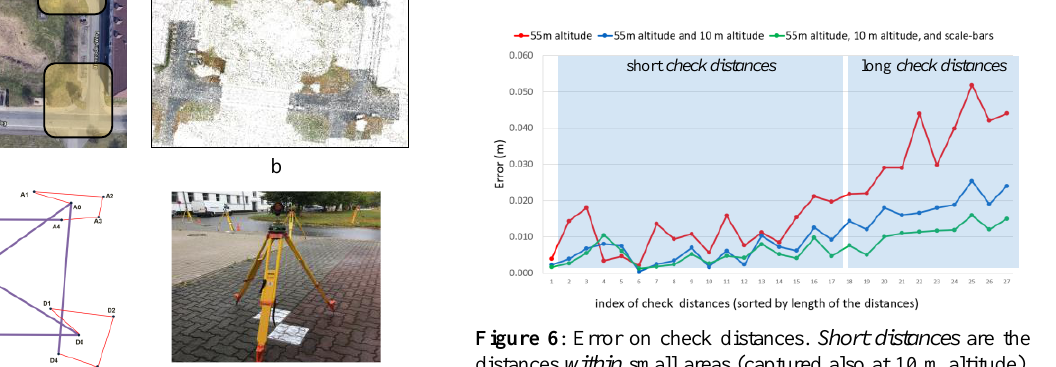
Figure 5: Sample scale-bars on 55m and 10m altitude flights. On each corner of the study area, a bunch of five points are measured using a MS50 Leica multi station. Similar to our first experiment these points serve as check points for computing ground truth distances and are not used in the block adjustment computations. Moreover, all four bunches of check points (one in each corner of the test area) are parts of a bigger closed surveying network with a standard deviation in XYZ of 1mm to make a global network adjustment. For this experiment, 27 check distances (Figure 4c) are measured in 3 different setups (Table 4). Setup 1: Main block (55m altitude) Setup 2: Setup 1 + small blocks in the corners (10 m altitude) Setup 3: Setup 2 + three scale-bars in each small block Table 4. Various setups in the second experiment By comparing the ground truth distances (surveying measurements) with measurements on each of the setups, the errors are computed and are reported in Figure 6.